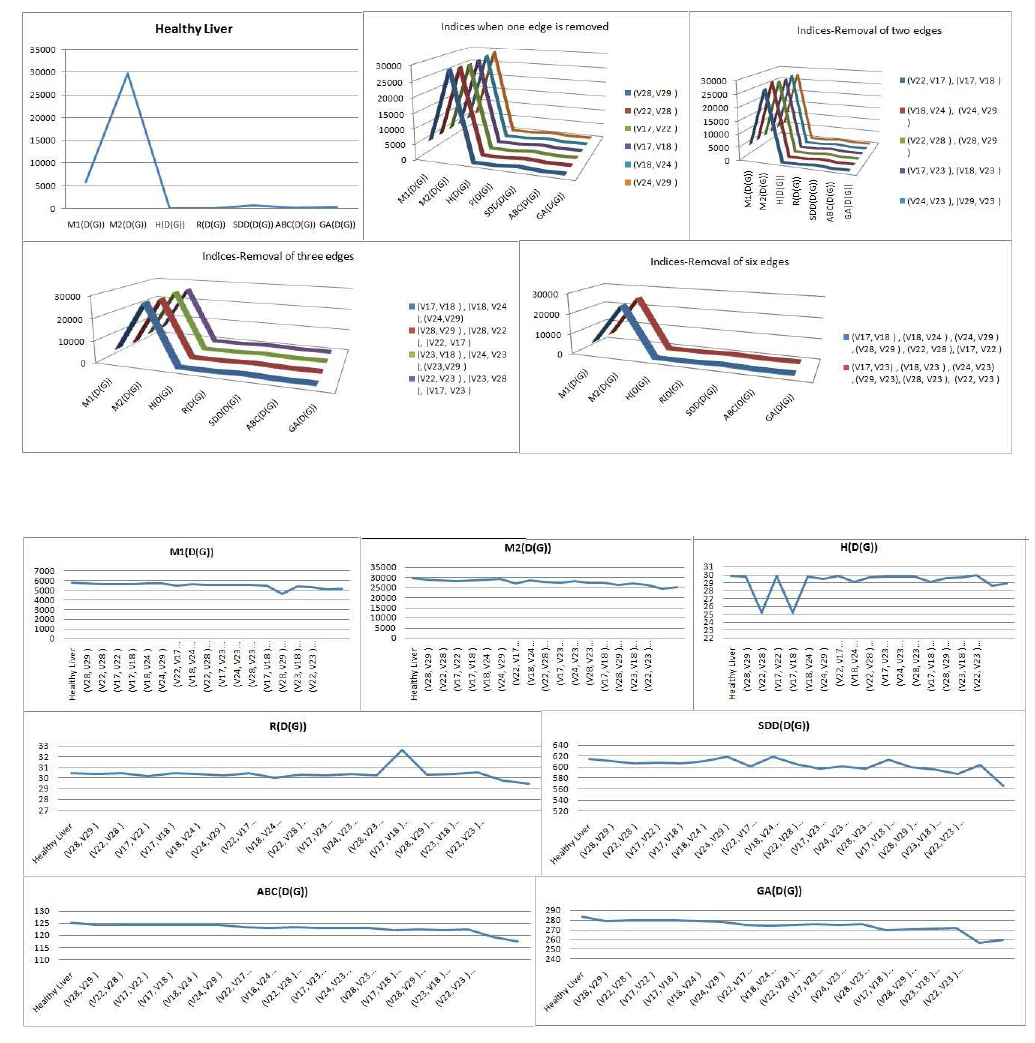
Fig. 8 Comparison between healthy and cirrhosis of Liver graph.